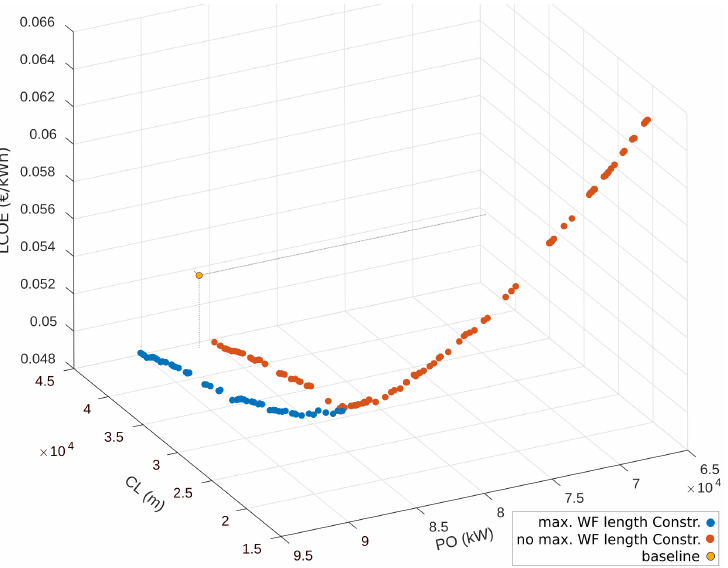
Figure 10. LCOE particularized for a decision maker in Denmark compared to PO and CL, for the set of F agg solutions and the baseline solution (yellow dot). lC (no-lC) solutions are represented with orange (blue)